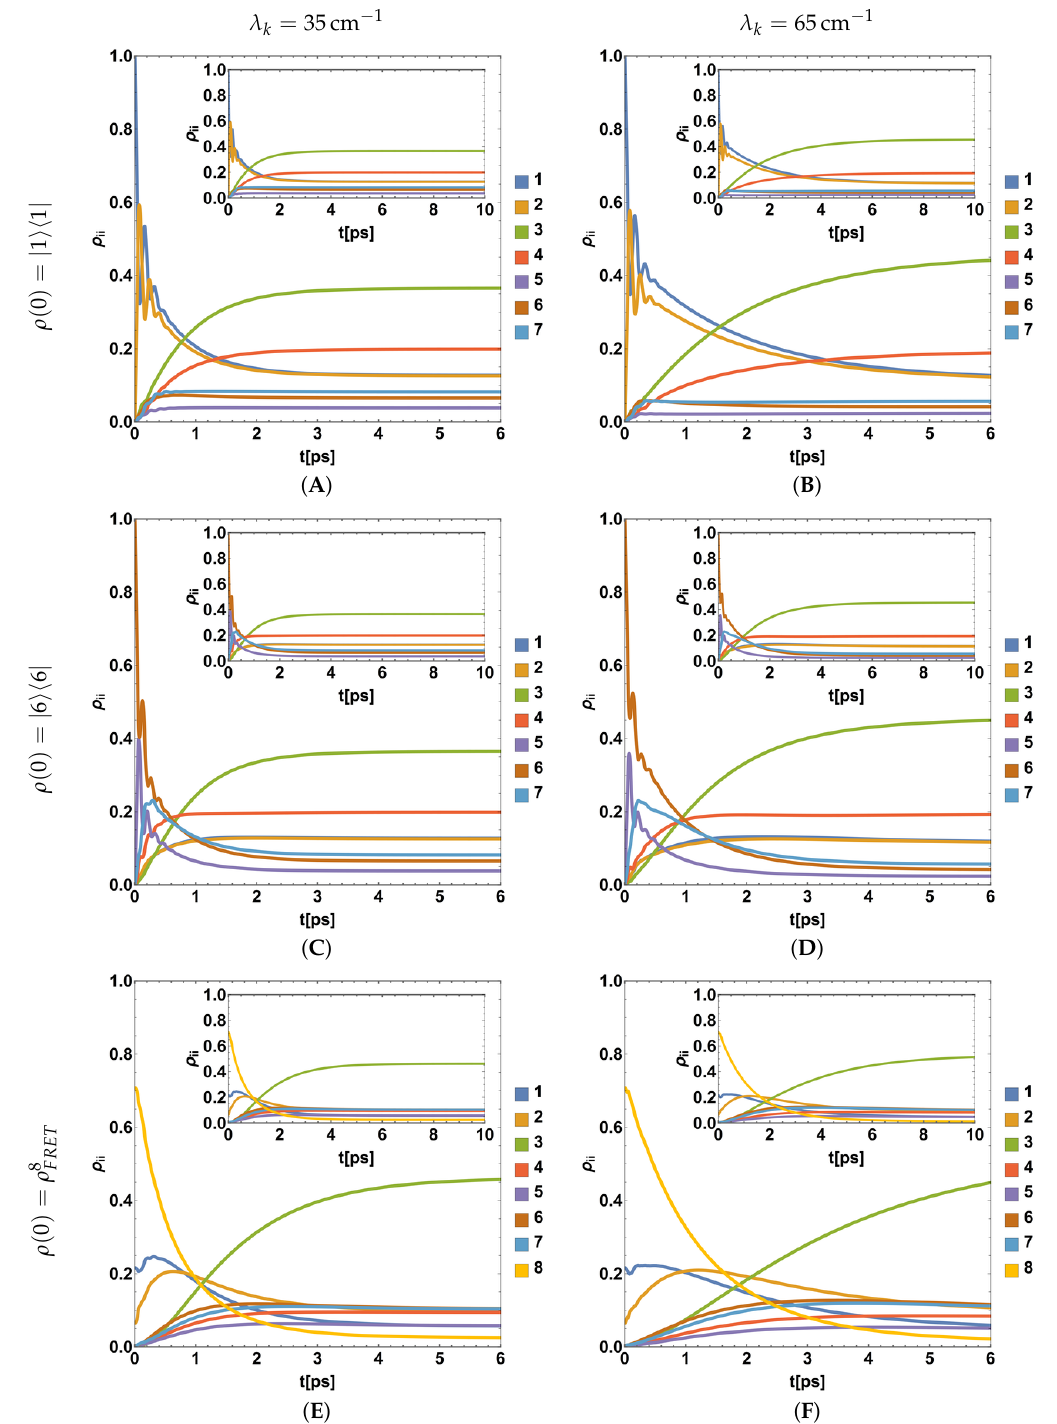
Figure 15. Population evolution in the first 6ps (10ps in the upper inset) for the 7 and 8 BChls in the FMO monomer of P. aestuarii with T = 293 ◦ K, γ k = 50cm − 1 . First and second columns for λ k = 35,65cm − 1 , respectively, and initial conditions: | 1 (cid:105)(cid:104) 1 | , | 6 (cid:105)(cid:104) 6 | and ρ 8 differences in the coherence and transference times. ( A ) λ k = 35cm − 1 , ρ 0 = | 1 (cid:105)(cid:104) 1 | ; ( B ) λ k = 65cm − 1 , ρ 0 = | 1 (cid:105)(cid:104) 1 | ; ( C ) λ k = 35cm − 1 , ρ 0 = | 6 (cid:105)(cid:104) 6 | ; ( D ) λ k = 65cm − 1 , ρ 0 = | 6 (cid:105)(cid:104) 6 | ; ( E ) λ k = 35cm − 1 , ρ 0 = ρ 8 ; ( F) λ k = 65cm − 1 , ρ 0 = ρ 8 FRET